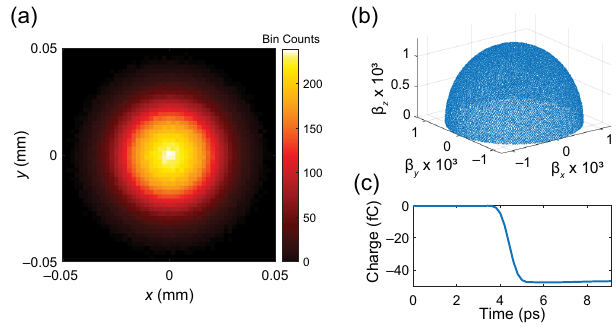
FIG. 5. Cumulative (a) spatial and (b) angular distribution of a beam. The radial distribution is set by the relative probability calculated using the HFSS fields on the tip. Emission is concen- trated in the center and there is very little emission at the edges. (c) The build up of charge versus time based on the emission versus phase shown in Fig. 4. The maximum value is never completely reached because some particles are lost while others are being emitted. One rf cycle is